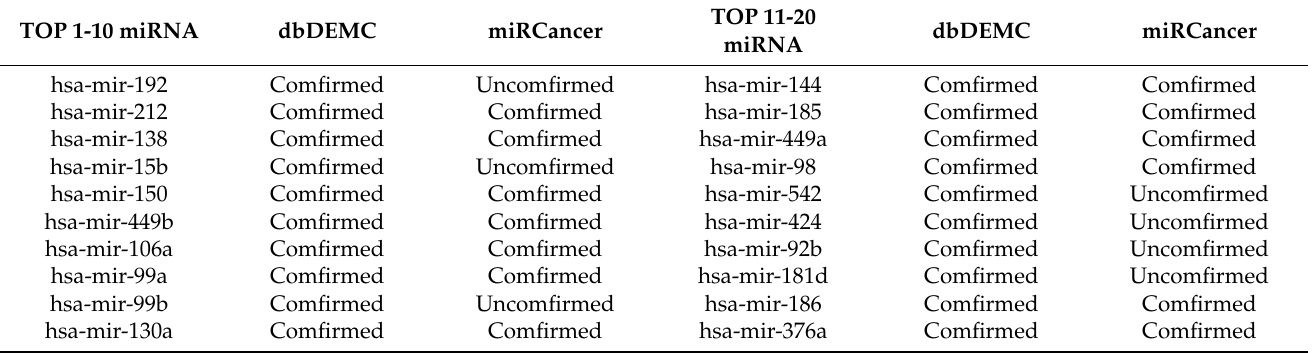
Table 6. Top 20 breast neoplasm-related miRNAs predicted by SGAEMDA based on HMDD